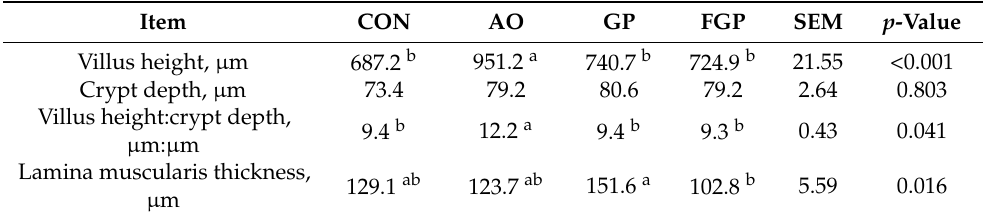
Table 7. Intestinal morphology of broiler chickens fed diets containing raw grape pomace, fermented grape pomace, and synthetic antioxidants 1